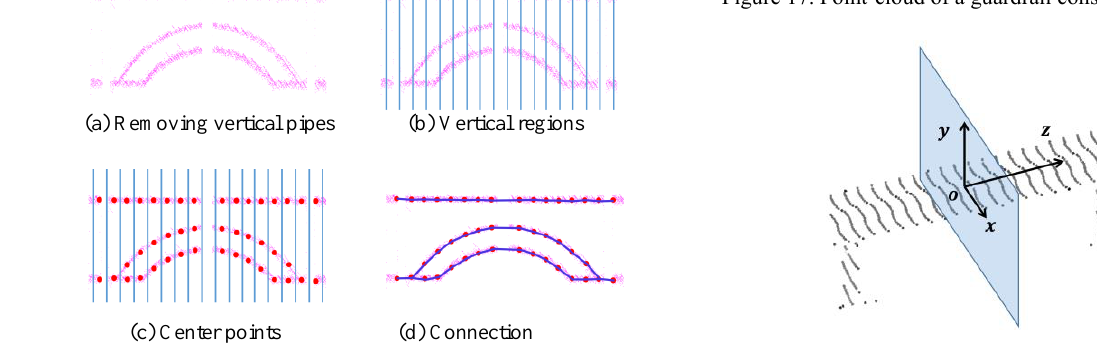
Figure 18. Projection plane